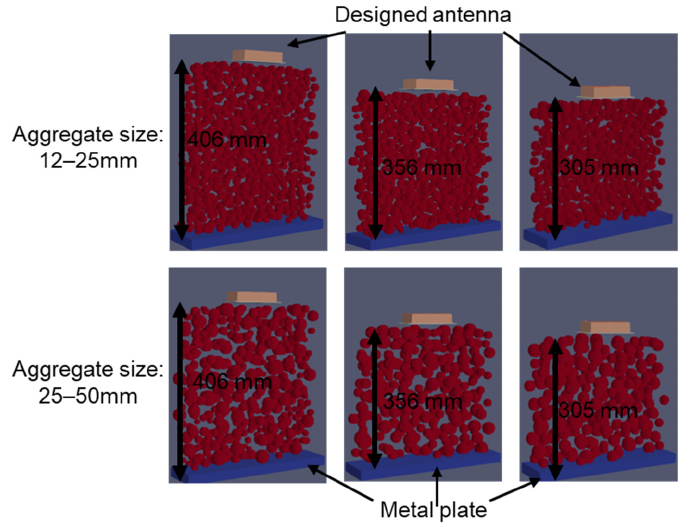
Figure 13. In homogenous simulation model generated from random aggregate particles for different depths at two different sizes of aggregates.